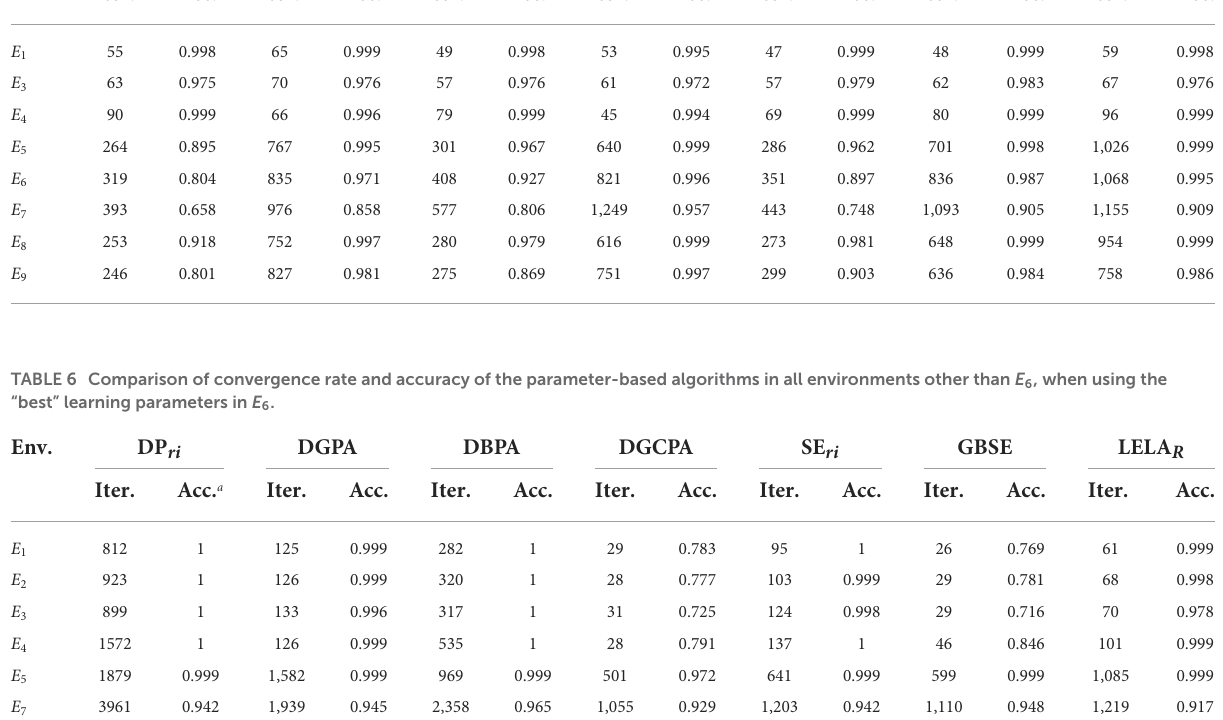
TABLE 5 Comparison of convergence rate and accuracy of the parameter-based algorithms in all environments other than E 2 , when using the “best” learning parameters in E 2 . Env. DP ri DGPA DBPA DGCPA SE ri GBSE LELA R Iter. Acc. Iter. Acc. Iter. Acc. Iter. Acc. Iter.